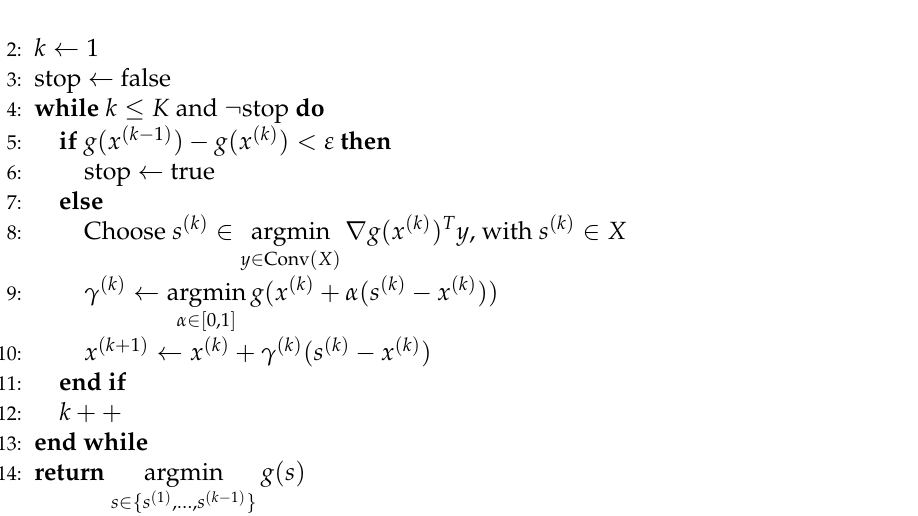
Algorithm 1 DFW: a Frank–Wolfe based algorithm to solve